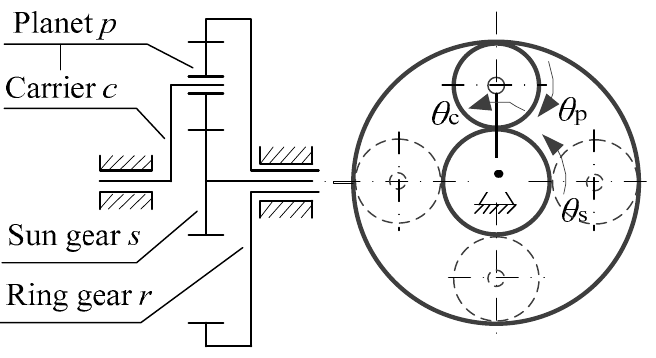
Figure 1. 2K-H planetary gear.